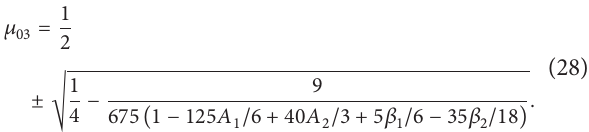
Figure 6: Correlation between 𝜇 and 𝐴 1 and 𝛽 1 = 0.01 , 𝛽 2 = 0.02 , and 𝐴 2 = 0.01